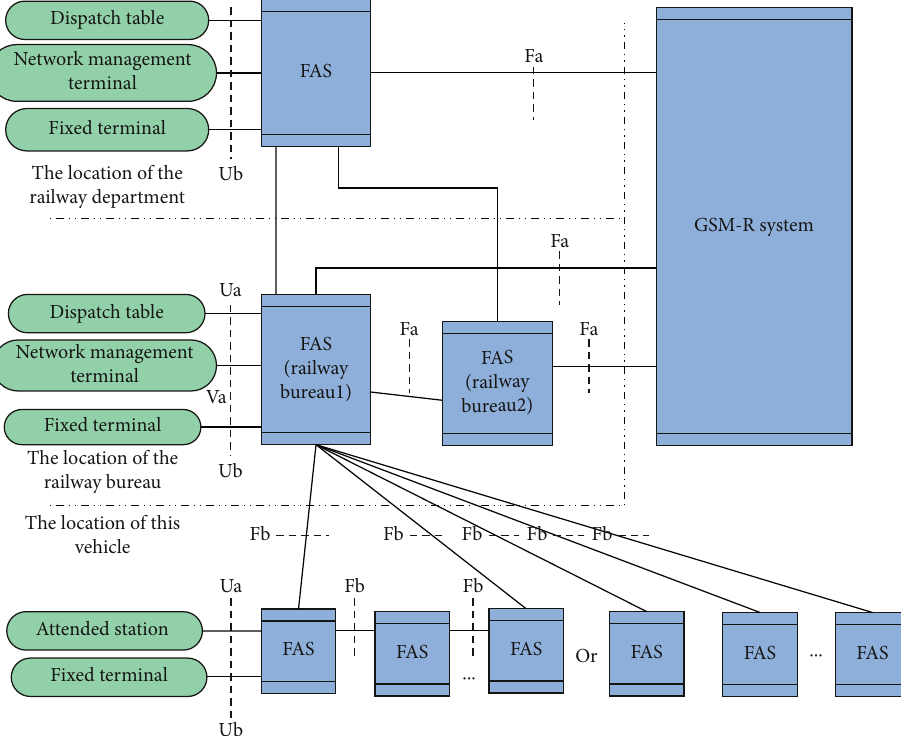
Figure 8: Networking mode of dispatching communication system.